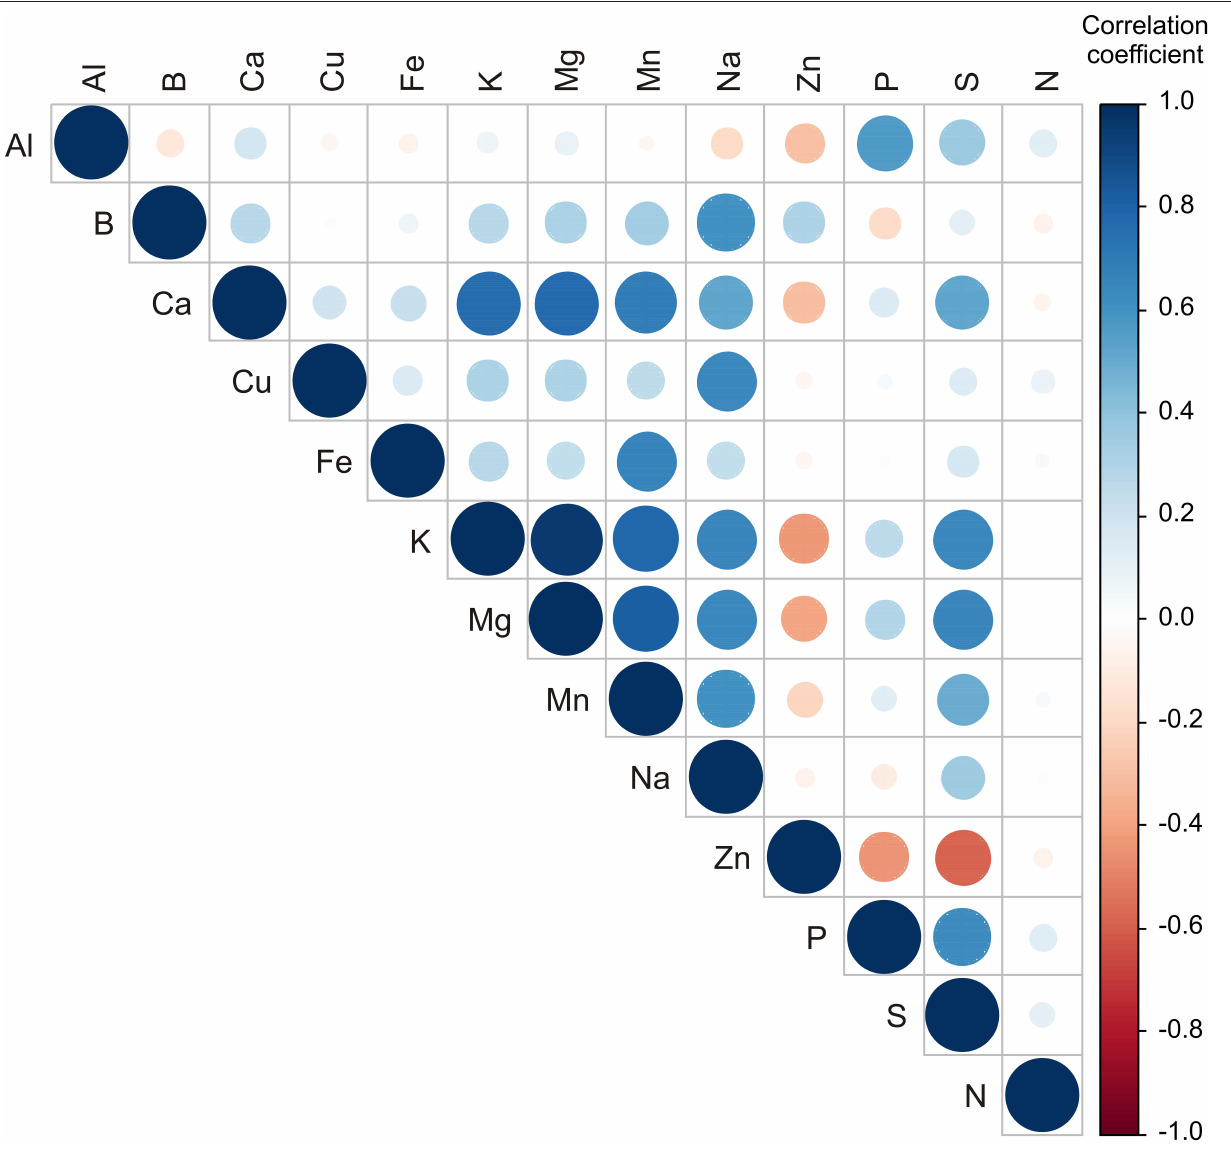
FIGURE 4 | Color correlation graph between metal content in apple